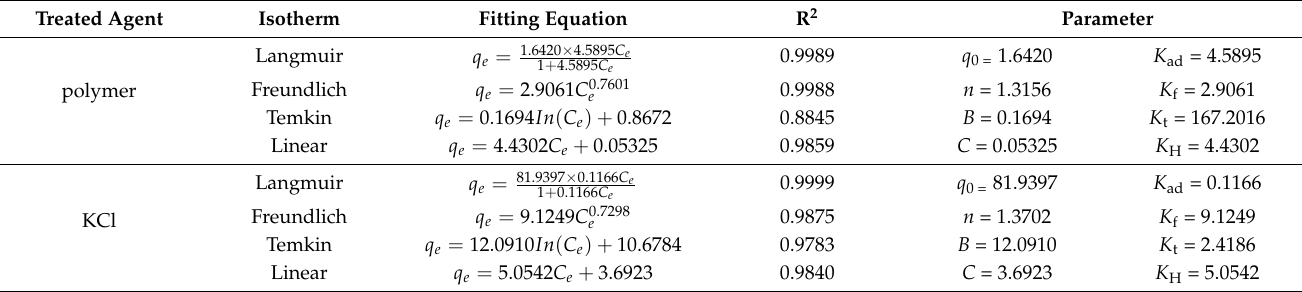
Figure 11. Schematic diagram of adsorption mechanism. Table 6. Relevant parameters of the adsorption isotherm.